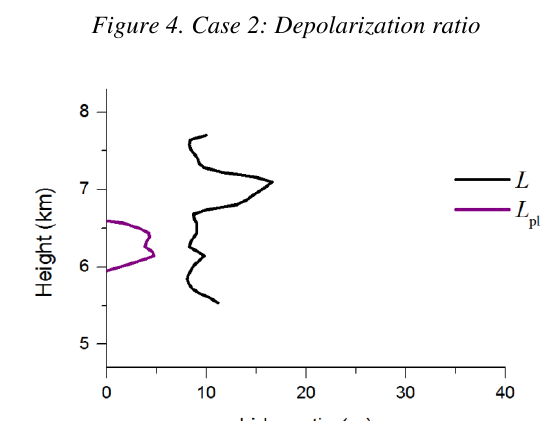
, the lidar ratio pl Figure 7. Effective tilt angle θ of the quasi-horizontally oriented plates and the plate percentage k retrieved from the experimental data of Figs.